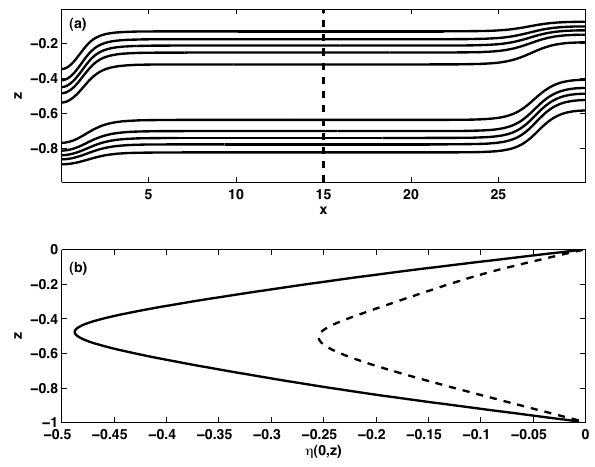
Fig. 4. Two-scale solitary wave (a) Ten isopycnals in black, (b) ver- tical profile of the isopycnal displacement at the wave crest (solid) and at the vertical dashed line in panel (a)